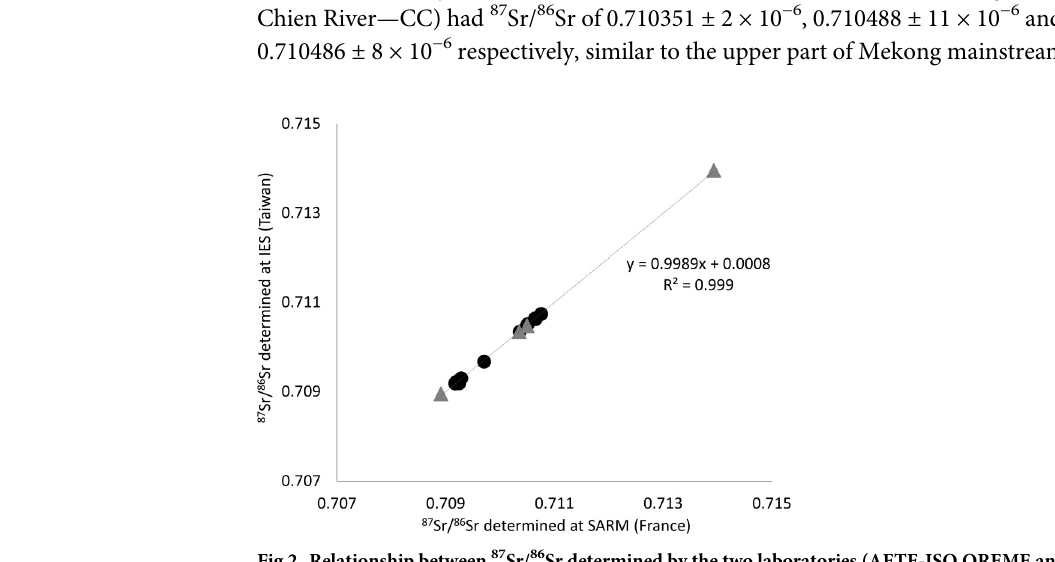
Fig 2. Relationship between 87 Sr/ 86 Sr determined by the two laboratories (AETE-ISO OREME and IES). Linear regression between the 87 Sr/ 86 Sr in water samples reported by IES (Taiwan) versus those reported by SARM (France). Black circles indicate sites along the Mekong mainstream, grey triangles indicate sites on tributaries and distributaries.